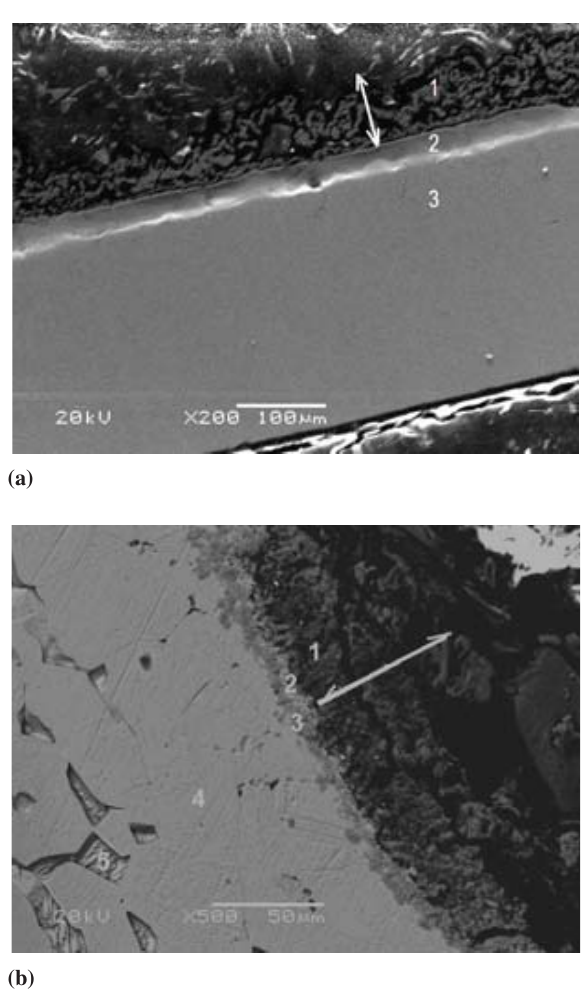
Figure 3. Cross sections of the oxidized specimen after oxidation at 973 K for 3 h, (a) after polishing specimen and (b) after etching specimen, showing the structure with oxide scale, intermediate layer and